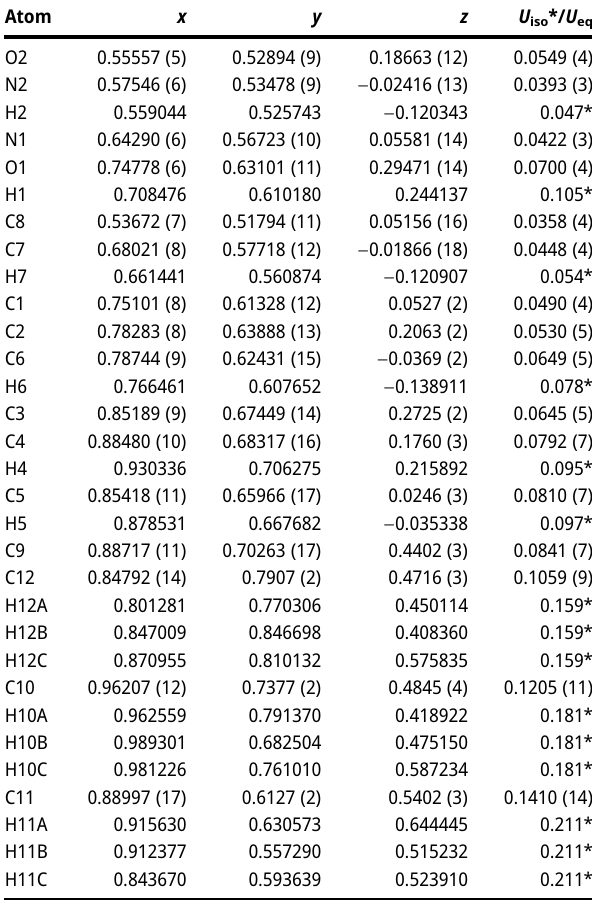
Table  : Fractional atomic coordinates and isotropic or equivalent isotropic displacement parameters (Å 